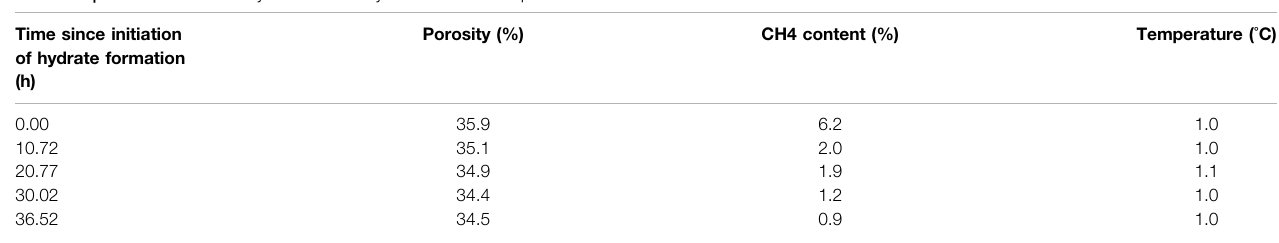
TABLE 1 | Details of scans analyzed from the hydrate formation